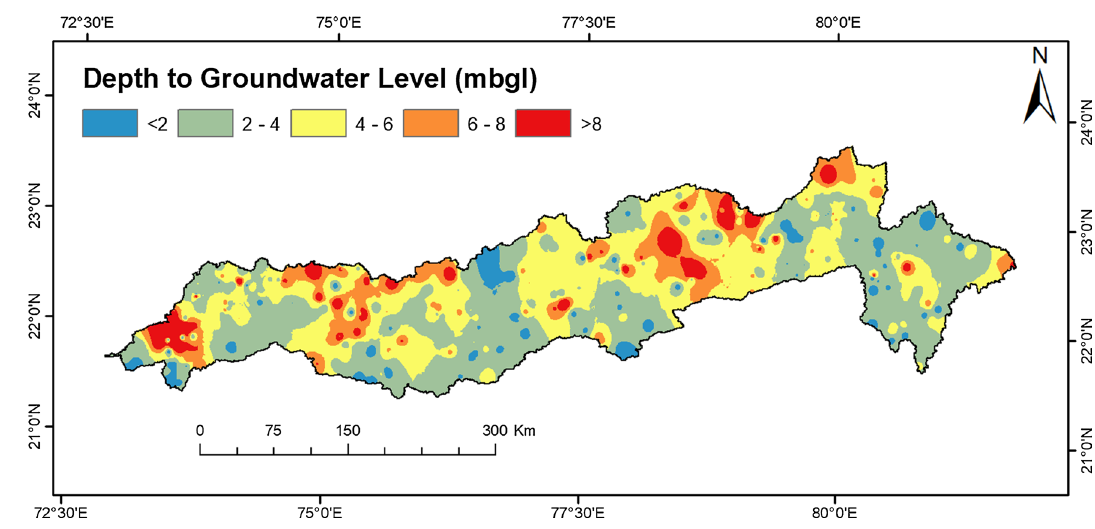
Fig. 5 Spatial distribution of depth to groundwater level over Narmada River